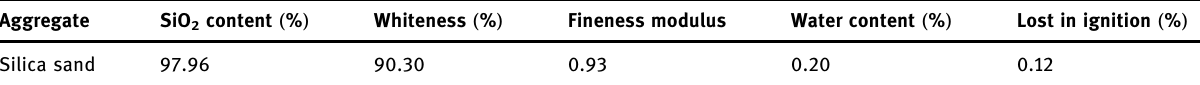
Table 3: Properties of the silica sand